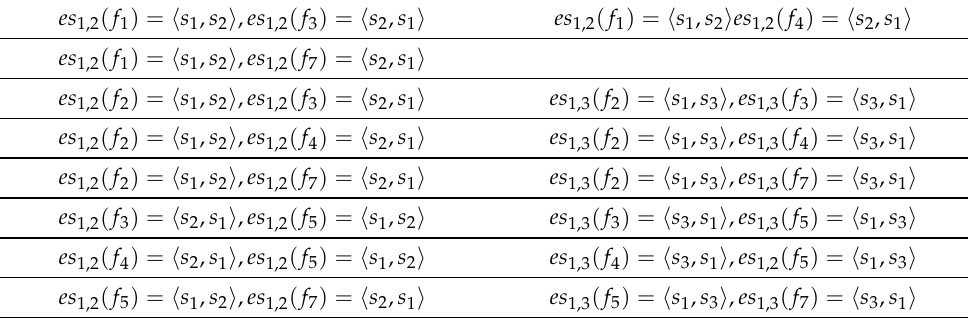
Table 9. Pairs of elementary sequences that distinguish faults.